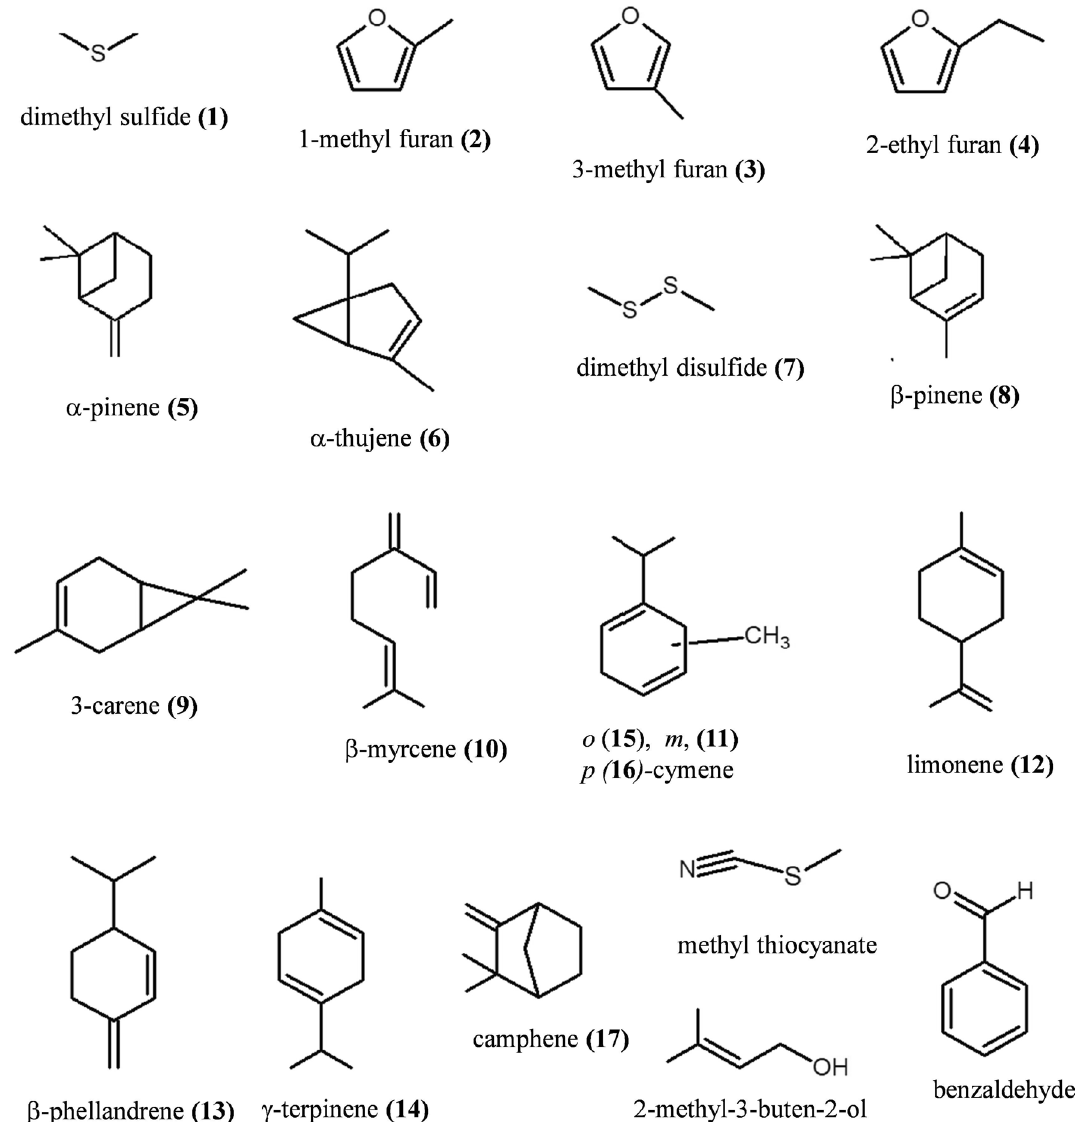
Figure 2. The chemical structures of the initial secretory compounds emitted from the live millipedes, Oxidus gracilis and Chamberlinius hualienensis . Each number of the compounds corresponds the peaks of TIC in Fig.